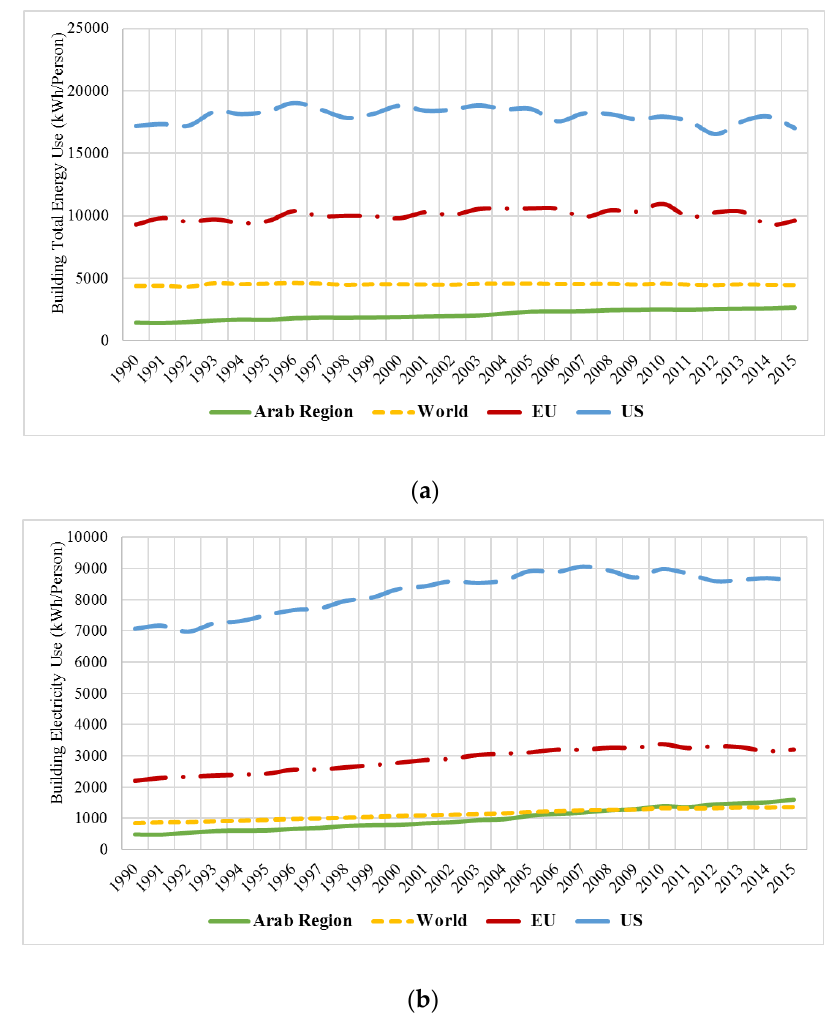
Figure 13. Annual per capita building ( a ) total final energy consumption and ( b ) total electricity consumption of the Arab region compared to those of the US, EU, and World.